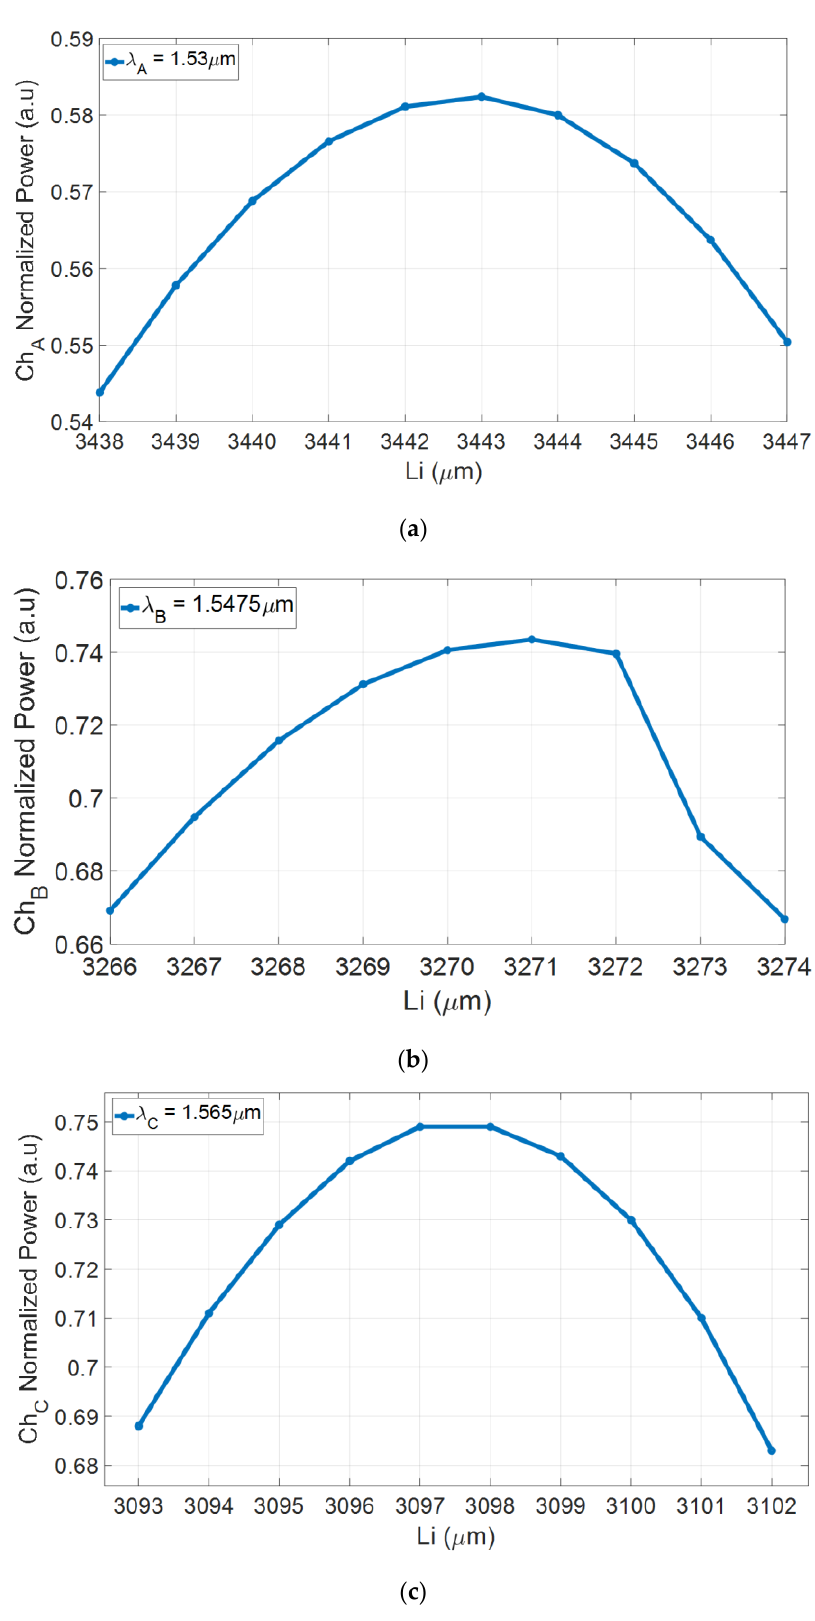
Figure 7. Normalized output taper power as a function of L i ( a ), L A (Ch A ), ( b ) L B (Ch B ), and ( c ) L c (Ch C ). Figure 8a–c shows the light propagation of the operating wavelengths from the input taper to the desired output taper (channel) through the MMI coupler. Figure 8a shows the light transmission of 1.53 μm wavelength from the input tilt taper to the output taper Ch A at 3.56 mm. Figure 8b shows